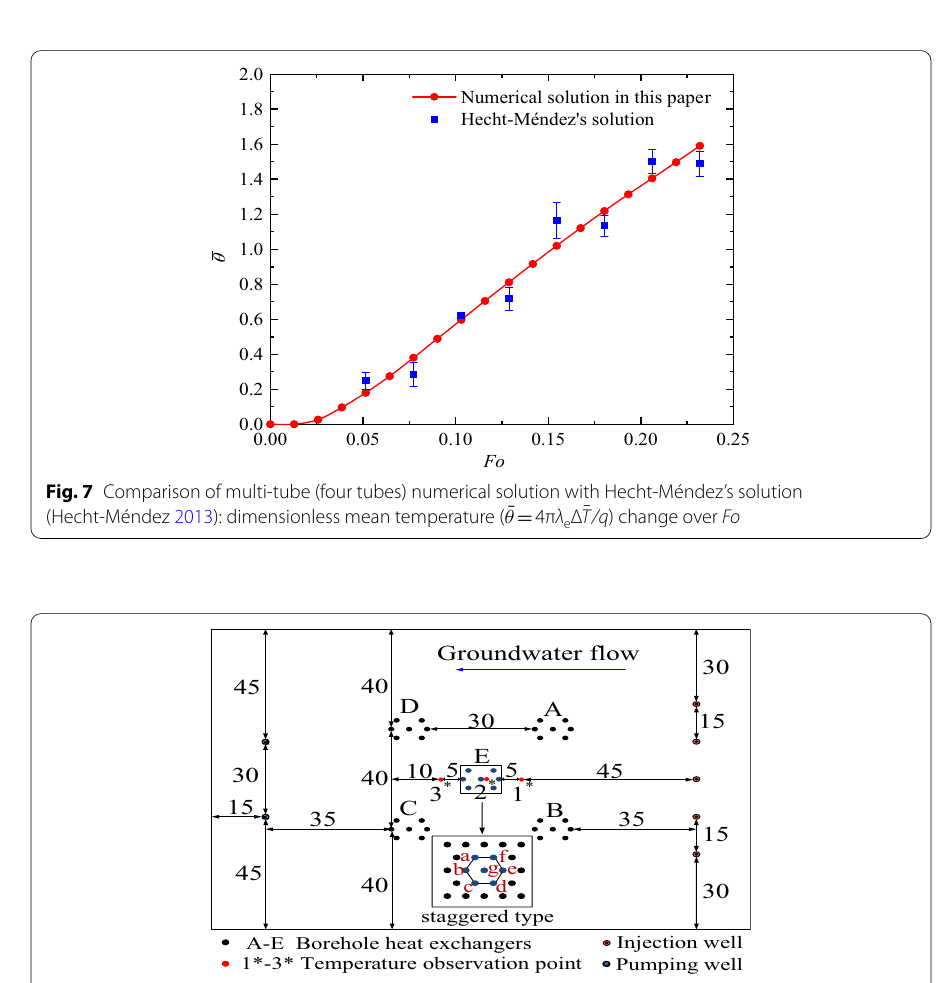
Fig. 8 Geometric arrangement of BHEs and pumping–injection wells (unit: